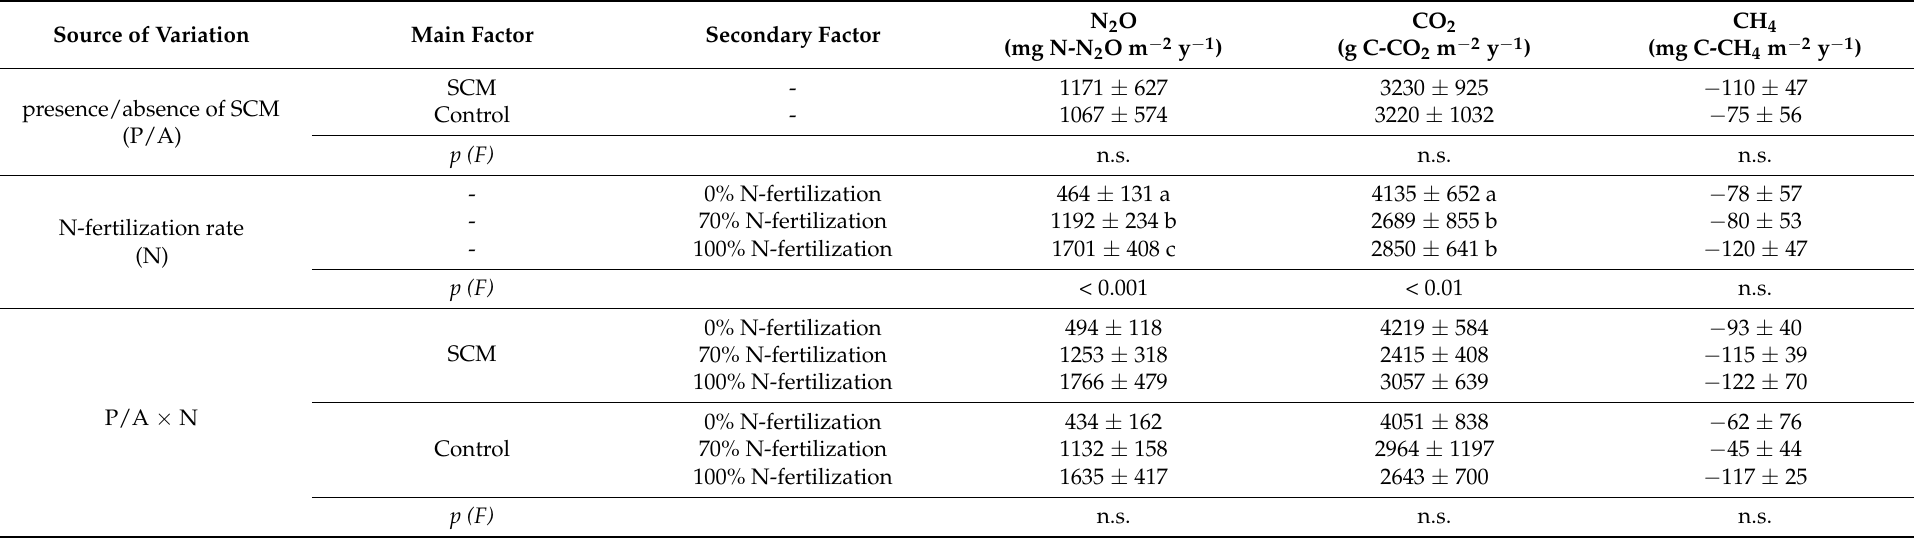
Table 4. Cumulated greenhouse gas emissions as affected by presence/absence of SCM (SCM vs control) and N-fertilization rate (0%, 70%, and 100% N-fertilization) during the entire experimental year (April 2019-April 2020). Different letters within the same source of variation indicate statistical significant differences between